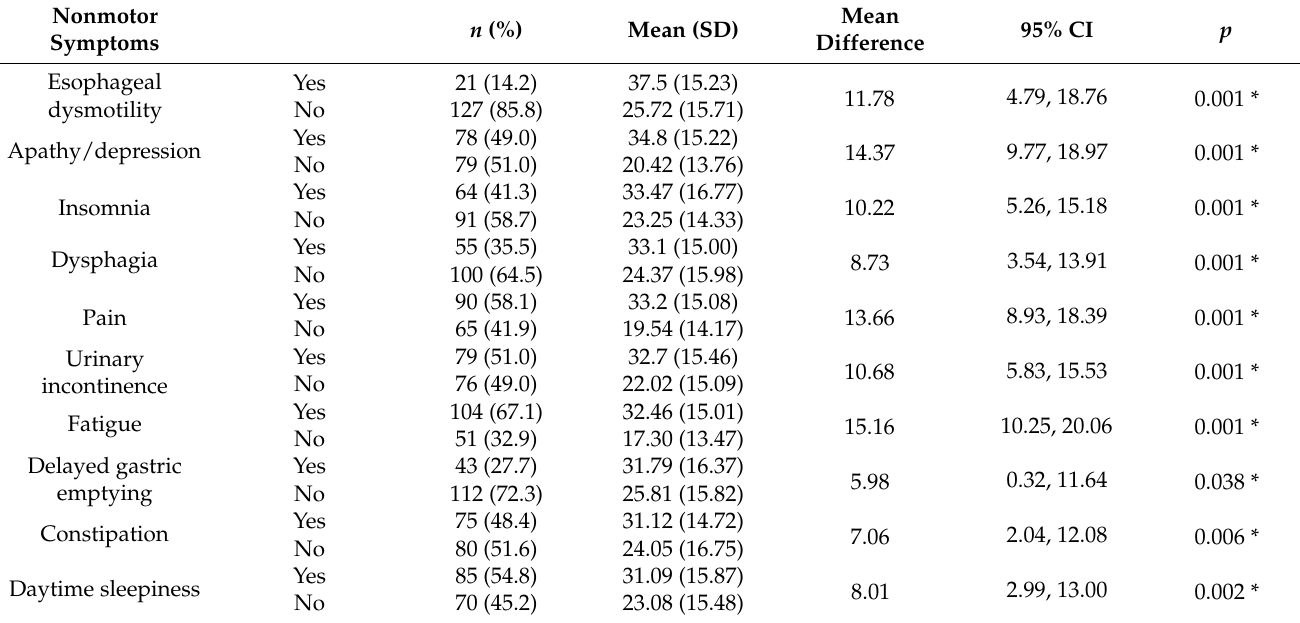
Table 5. Association between the PDQ-39 SI and the presence of